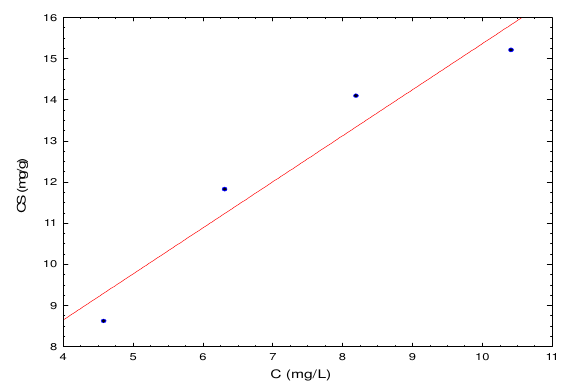
C Fig. 22. Plot the concentrations according to linear adsorption isotherm for TOC.